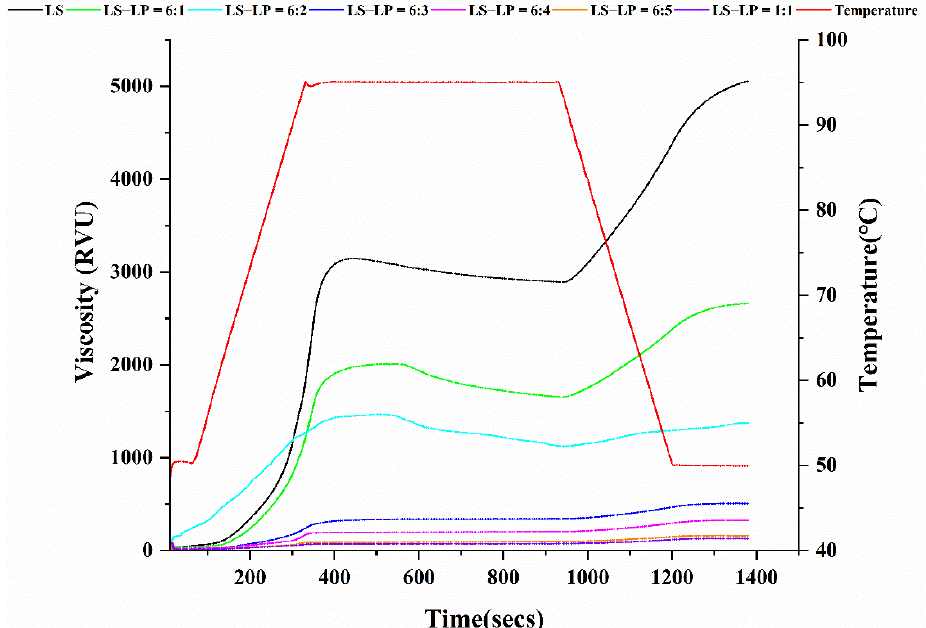
Figure 6. The pasting curve of lotus seed starch–protein mixture. Note: The figure displayed that lotus seed starch–protein mixture (LS-LP). LS indicates lotus seed starch. LS-LP = 6:1–5 or 1:1 indicates lotus seed starch–protein with different ratios.